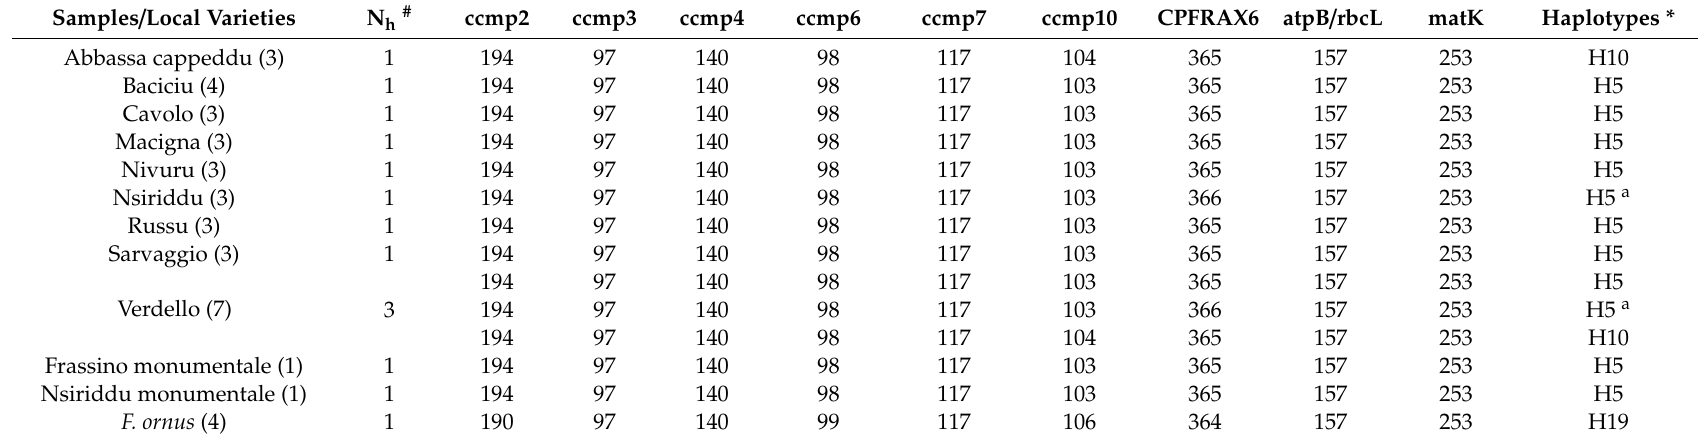
Table 2. Haplotypes detected based on fragment length polymorphism using six chloroplast microsatellites (cpSSR) and three plastid DNA regions in the germplasm belonging to the studied manna ash collection. F. ornus was used as reference. In bracket the number of samples analyzed belonging to each local variety / species. Samples / Local